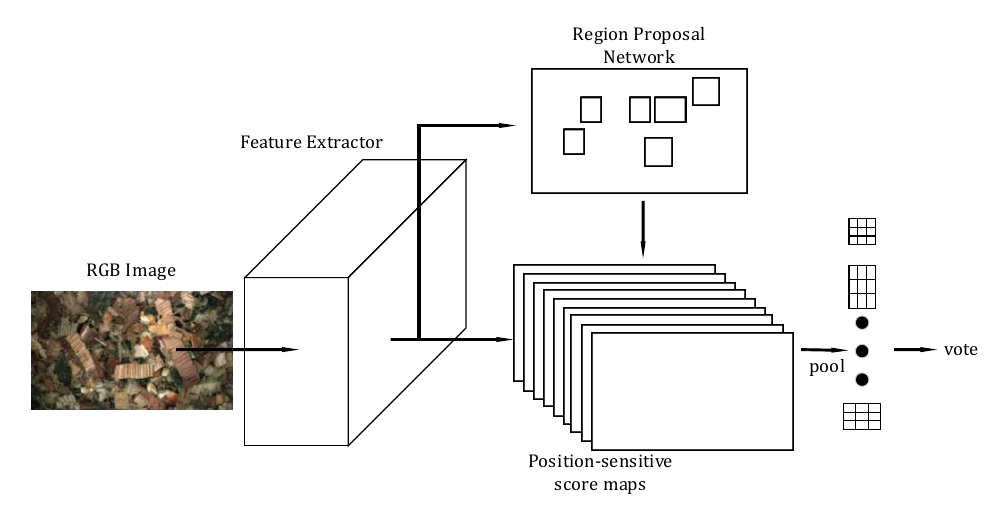
Figure 5. The R-FCN architecture illustrating an image being passed through a number of convolutional layers. RoIs are computed from a RPN on the final convolutional layer, these RoIs are classified through the coloured position-sensitive score